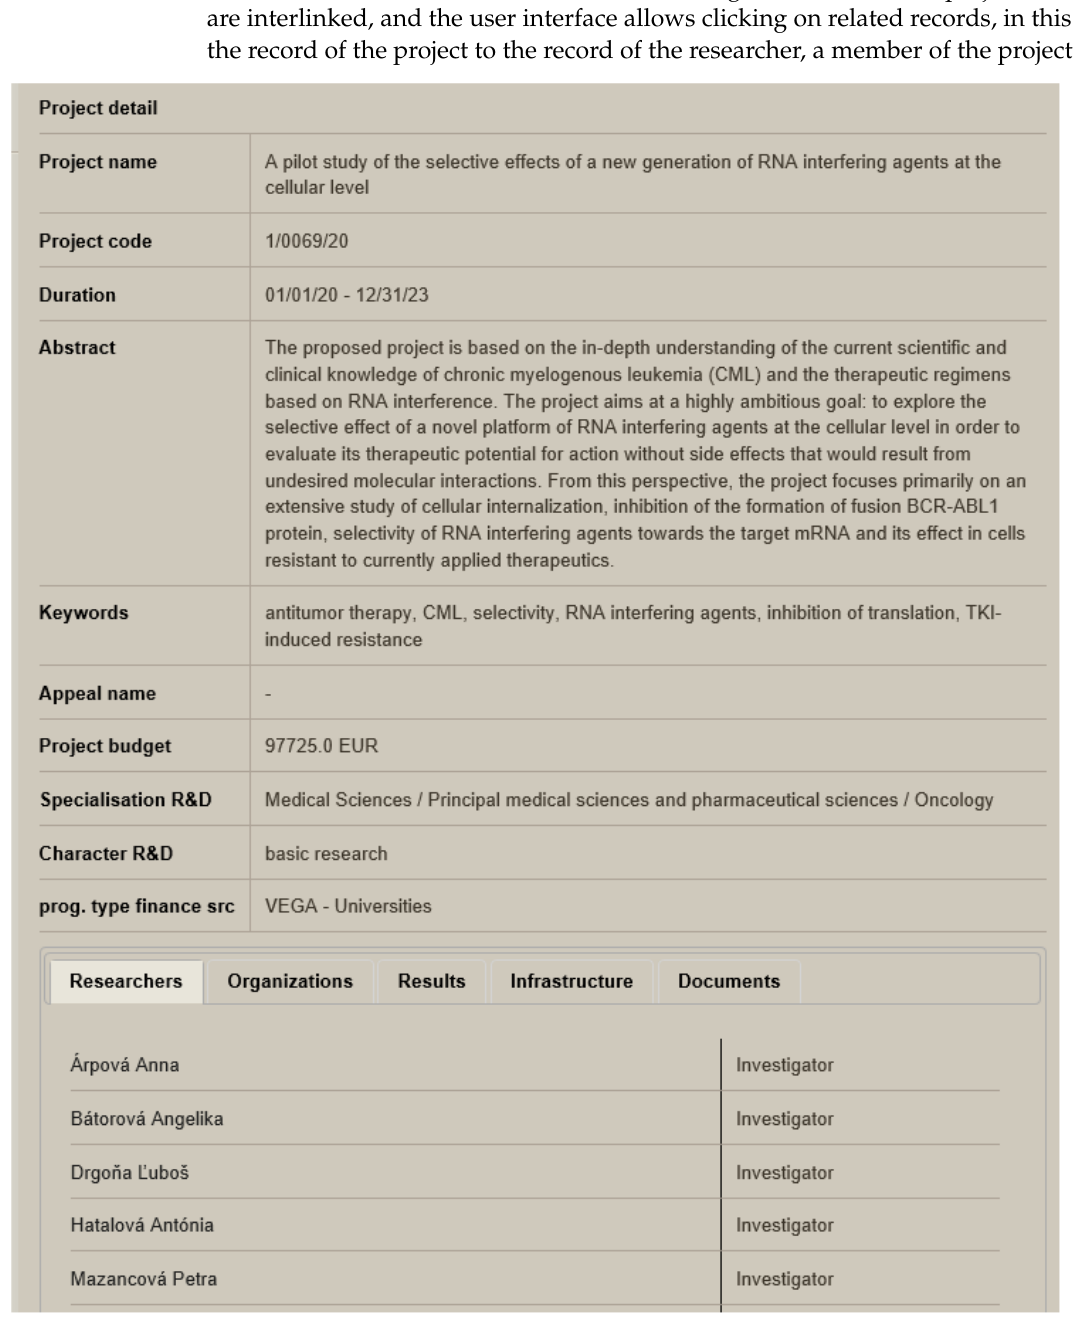
Figure 3. Detail of the project record with the research team.